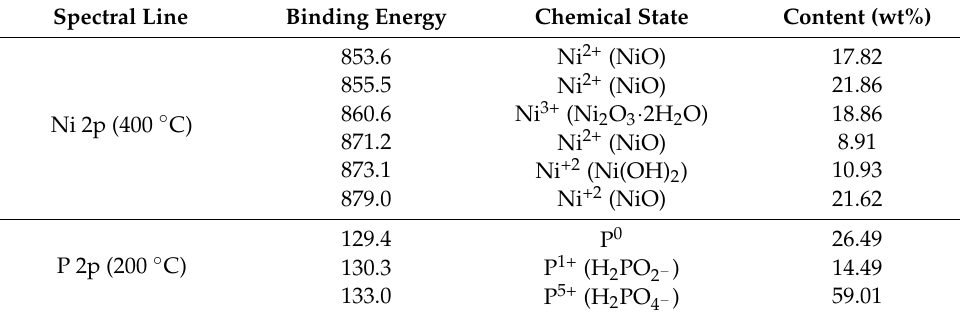
Table 2. Calibration results of Ni and P peaks during